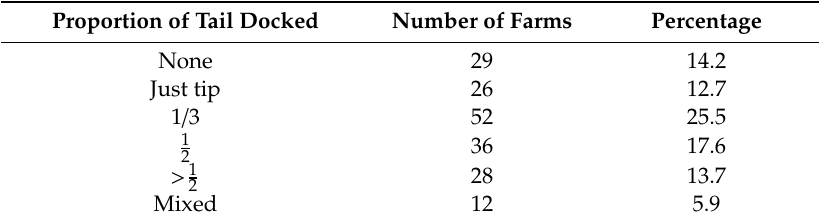
Table 3. Distribution of farms with di ff ering proportion of tail